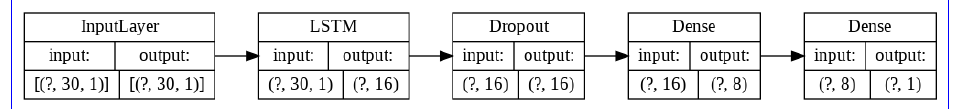
Figure 2. The final neural network evaluated and deployed to DMGs system. 7 prediction models are trained; one for each day in the outlier